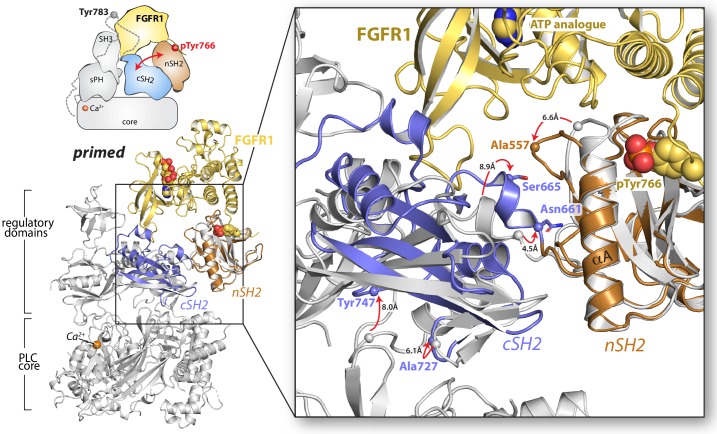
Proposed mechanism for priming of PLC-γ1 by FGFR1.The structure of the SH2 domain array of PLC-γ1 bound to the kinase domain of FGFR1 (nSH2 domain, orange; cSH2 domain, blue; FGFR1 kinase domain, yellow; PDB code: 3GQI) was superimposed on the structure of autoinhibited PLC-γ1 (gray) using the nSH2 domain. Red arrows indicate displacement of select residues (spheres represent Cα atoms).